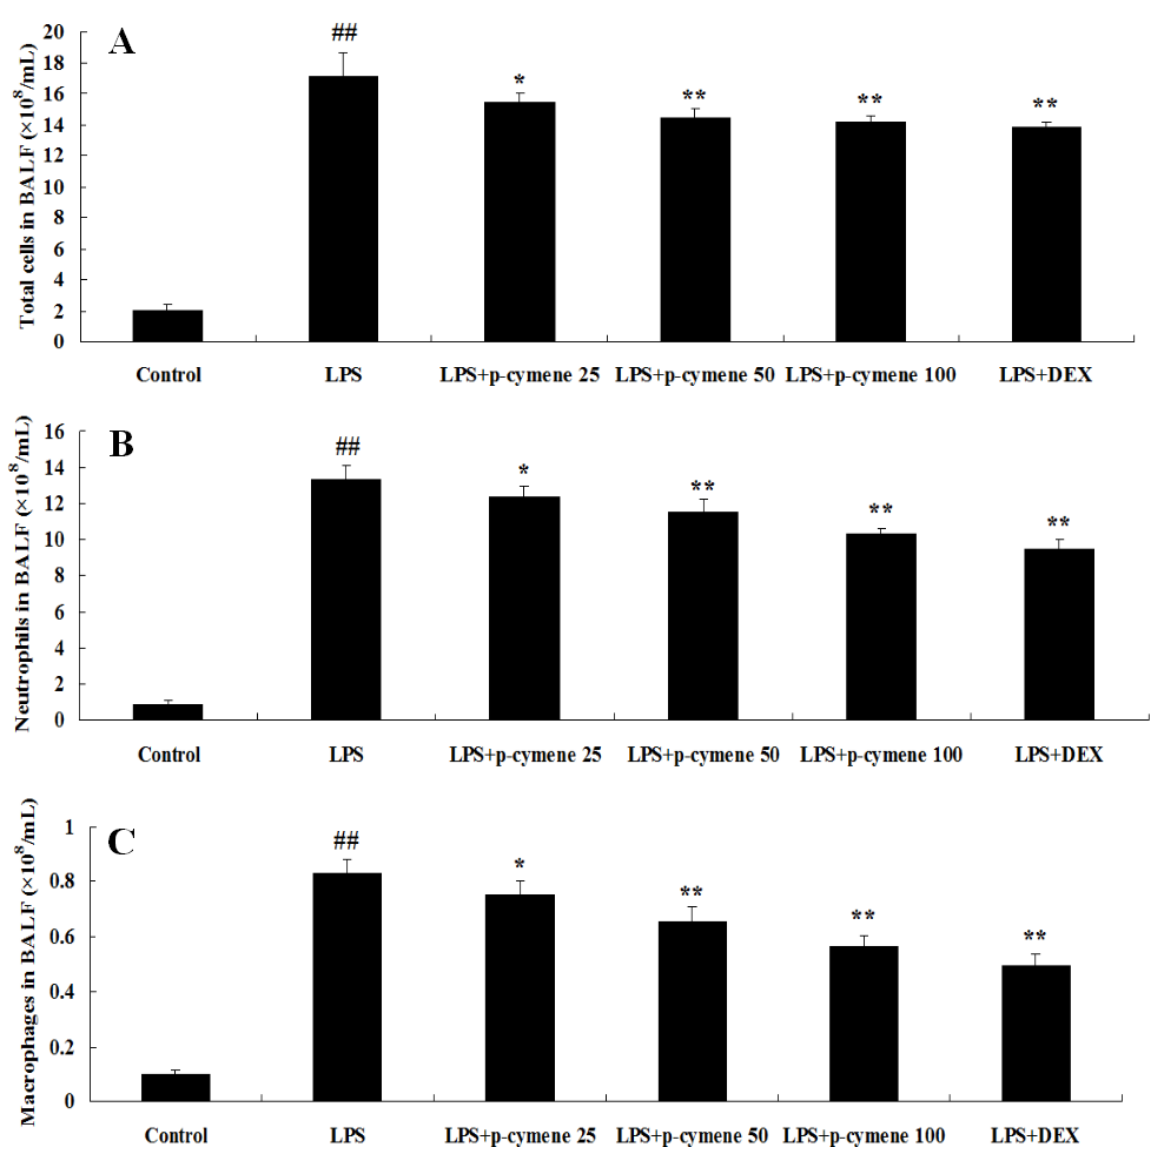
Figure 2. Effects of p -cymene on the number of total cells, neutrophils, and macrophages in the BALF of mice with LPS-induced ALI. Mice were given an intraperitoneal injection of p -cymene (25, 50 or 100 mg/kg) 1 h prior to an i.n. administration of LPS. BALF was collected at 7 h following LPS challenge to measure the number of total cells ( A ), neutrophils ( B ), and macrophages ( C ). The values presented are the mean ± SEM (n = 6